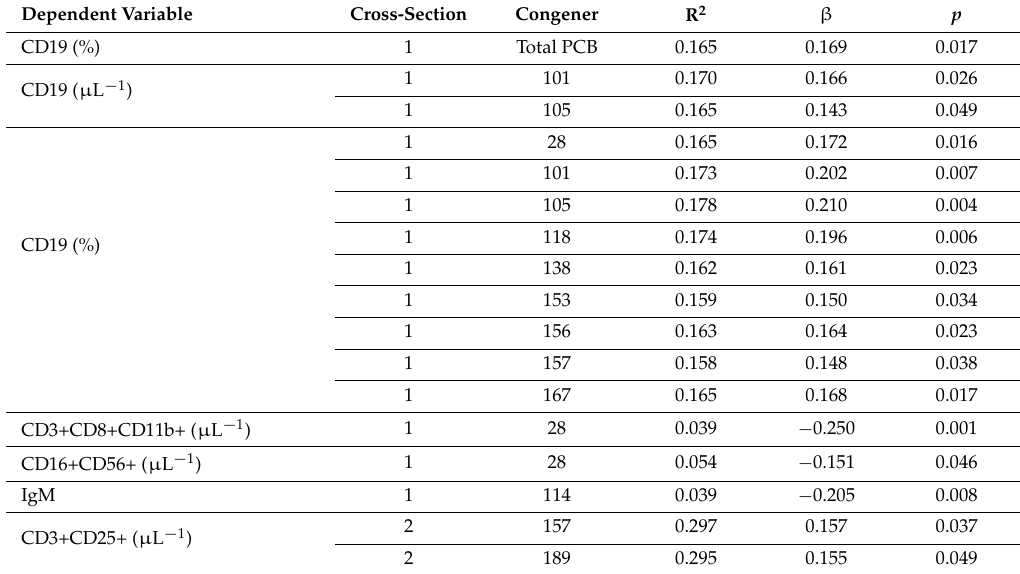
Table 3. Overview of significant correlations between PCB levels and immunological parameters. Dependent Variable